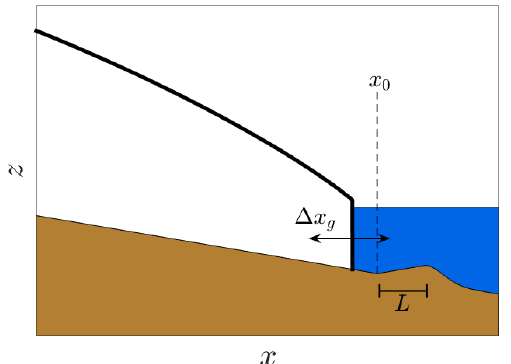
Figure 1. Schematic of bed configuration for model experiments. Solid black line indicates ice-sheet profile. Brown shaded region is bedrock. Blue shaded region is seawater. x 0 is the horizontal posi- tion where the retrograde section begins. L is the length of the ret- rograde section. (cid:49)x g indicates the range over which the grounding line migrates during thermal oscillations.